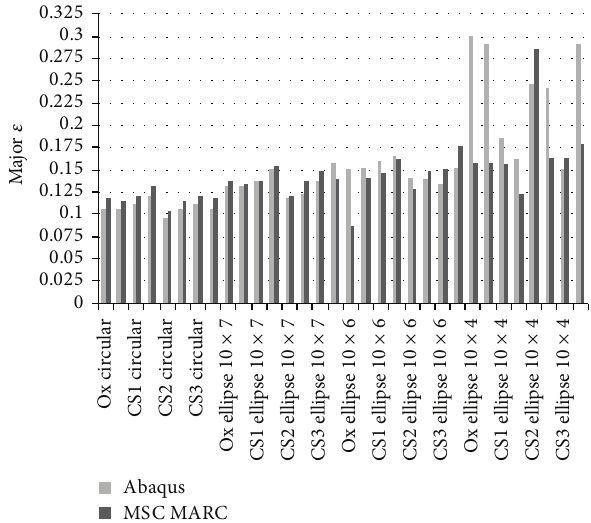
Figure 24: Maximum strain for the bulge tests using Abaqus and MSC-MARC.